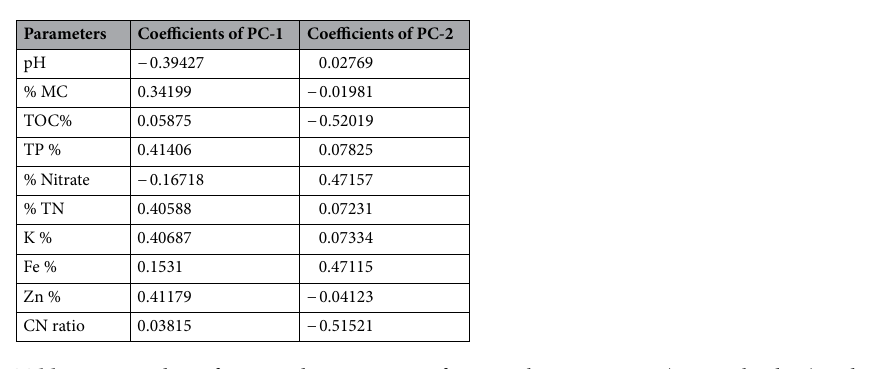
Table 3. Score data of extracted eigenvectors of principal component-1 (56.90% loading) and principal component-2 (36.20%